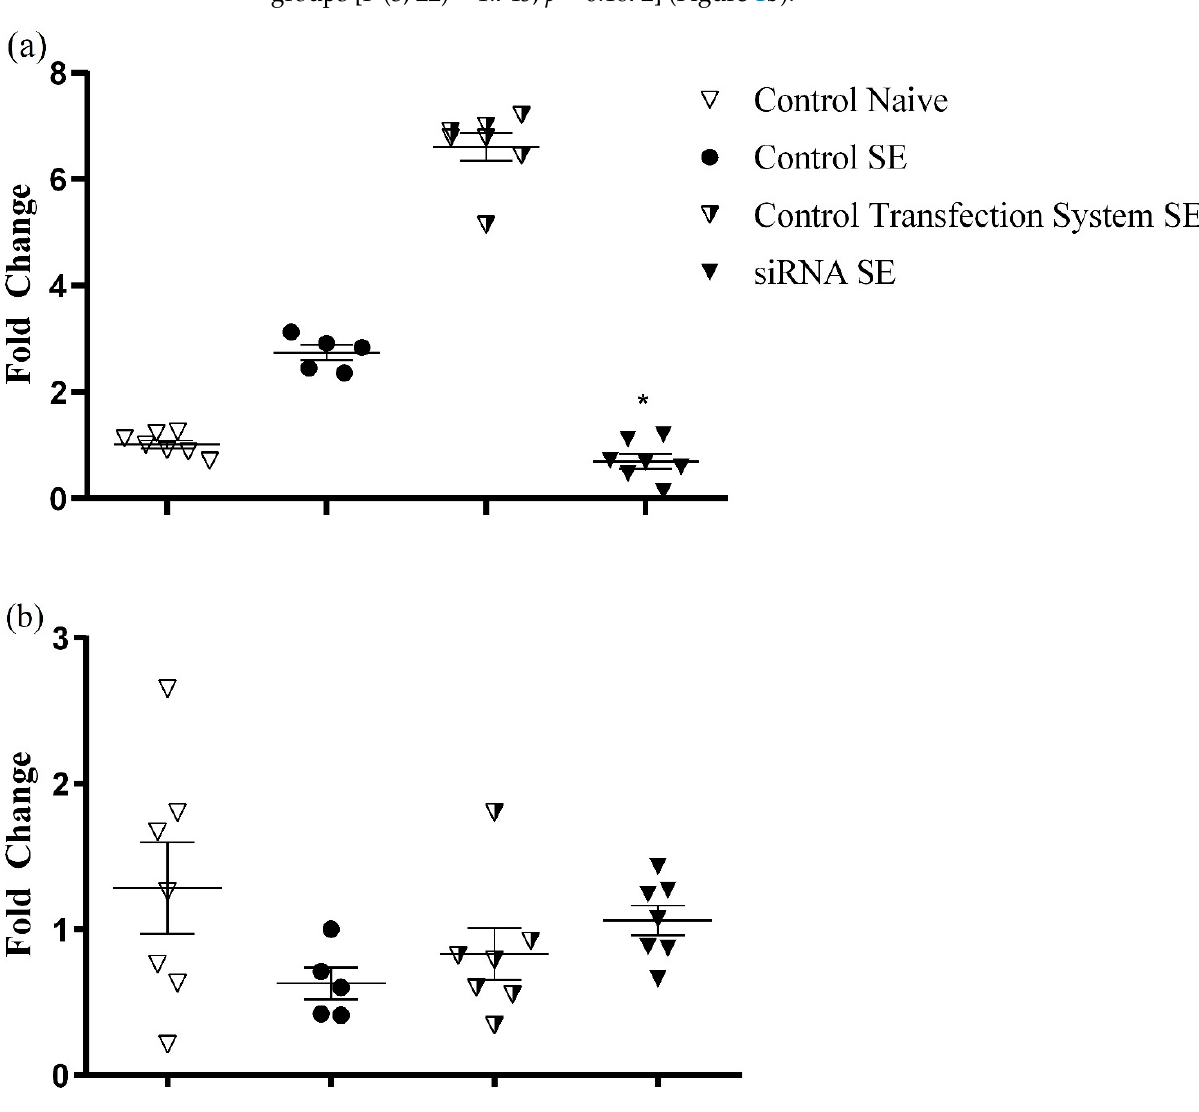
Figure 1. Relative gene expression of the GluN1 gene normalized with GAPDH (5 µ g/rat siRNA- GluN1), compared to controls. Bars show the fold change (2 − ∆∆ Ct ) average for each group. Statistical analysis was performed using one-way ANOVA followed by Dunnett’s multiple comparison test and Shapiro–Wilk * ( p < 0.05). Animal groups were divided as follows: CONTROL NAÏVE (no intranasal treatment/no SE induction after 14 days of group formation); CONTROL SE (no intranasal treatment/SE induction after 14 days of group formation); CONTROL TRANSFECTION SYSTEM SE (intranasal treatment with transfection system/SE induction after 14 days of intranasal treatment); siRNA SE: (intranasal treatment with siRNA/SE induction after 14 days of intranasal treatment). ( a ) Hippocampus; ( b ) Cortex.